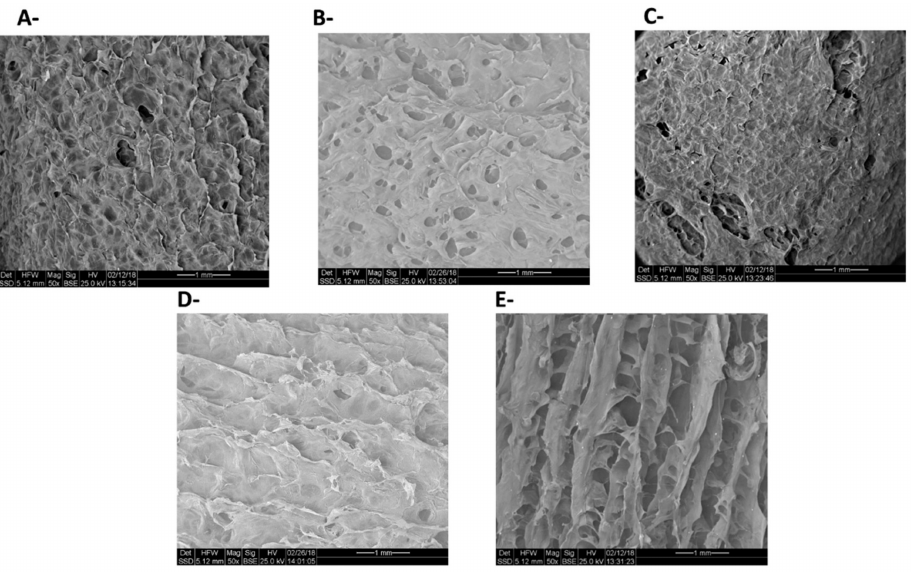
Figure 7. SEM micrographs of ( A ) i ; ( B ) i -PdCl 2 ; ( C ) i-TPP; ( D ) i -TPPTS; ( E ) i -PdCl 2 (TPPTS) 2 .